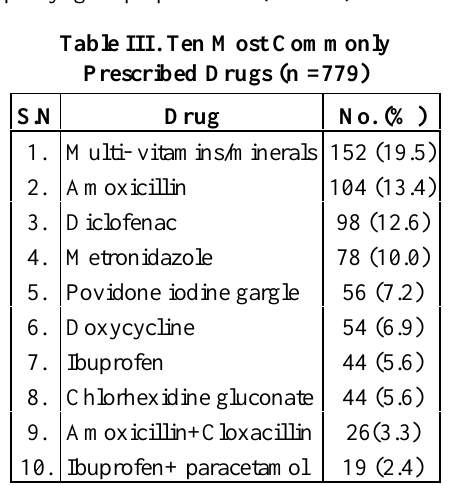
Table III. Ten Most Commonly